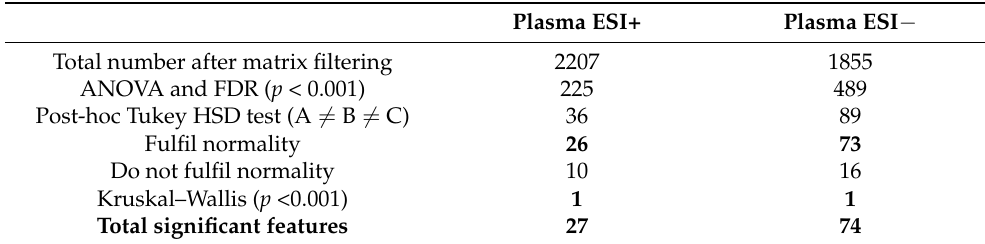
Table 2. Number of features of interest in the Plasma ESI+ and Plasma ESI − data sets after applying univariate statistical analysis.